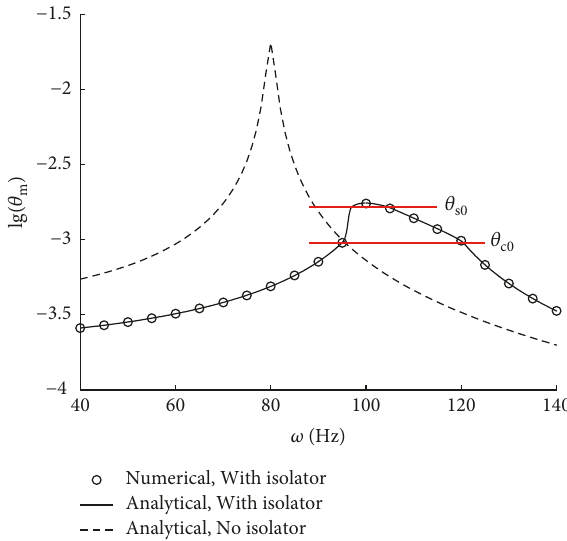
Figure 7: Influence of isolator on dynamic response.